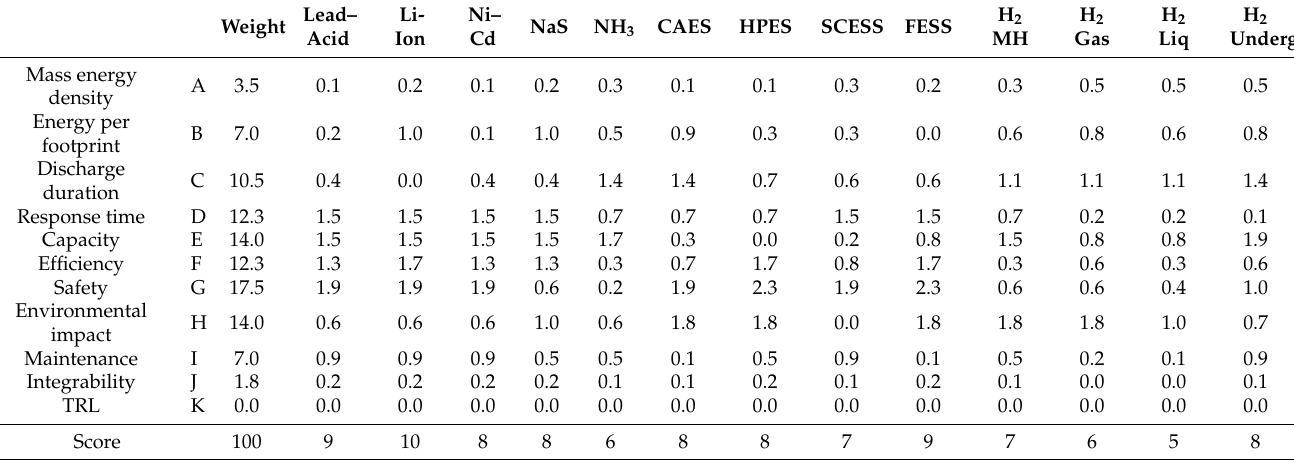
Table A7. General matrix of technology comparison for Scenario